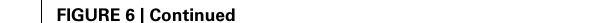
FIGURE 6 | Continued DTX: 179.3 ± 59.2 ms) or HF (control: 79.4 ± 32.8 ms, DTX: 197.4 ± 73.6 ms) neurons. (G) NotonotopicdifferencesintheeffectofDTXonIPSPhalfwidth. (H) 1/CV 2 was not significantly changed in LF, MF, or HF neurons after